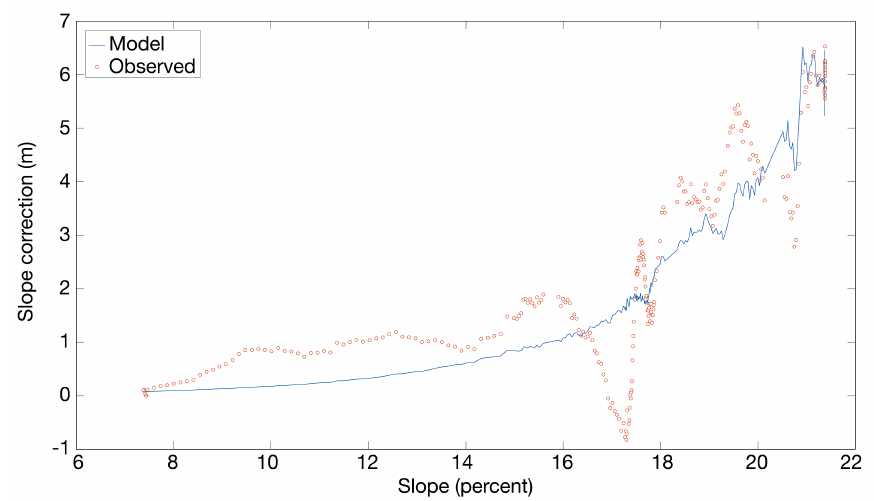
Figure 13. Slope correction due to the increasing intertidal beach slope between Transects 1 and 5.